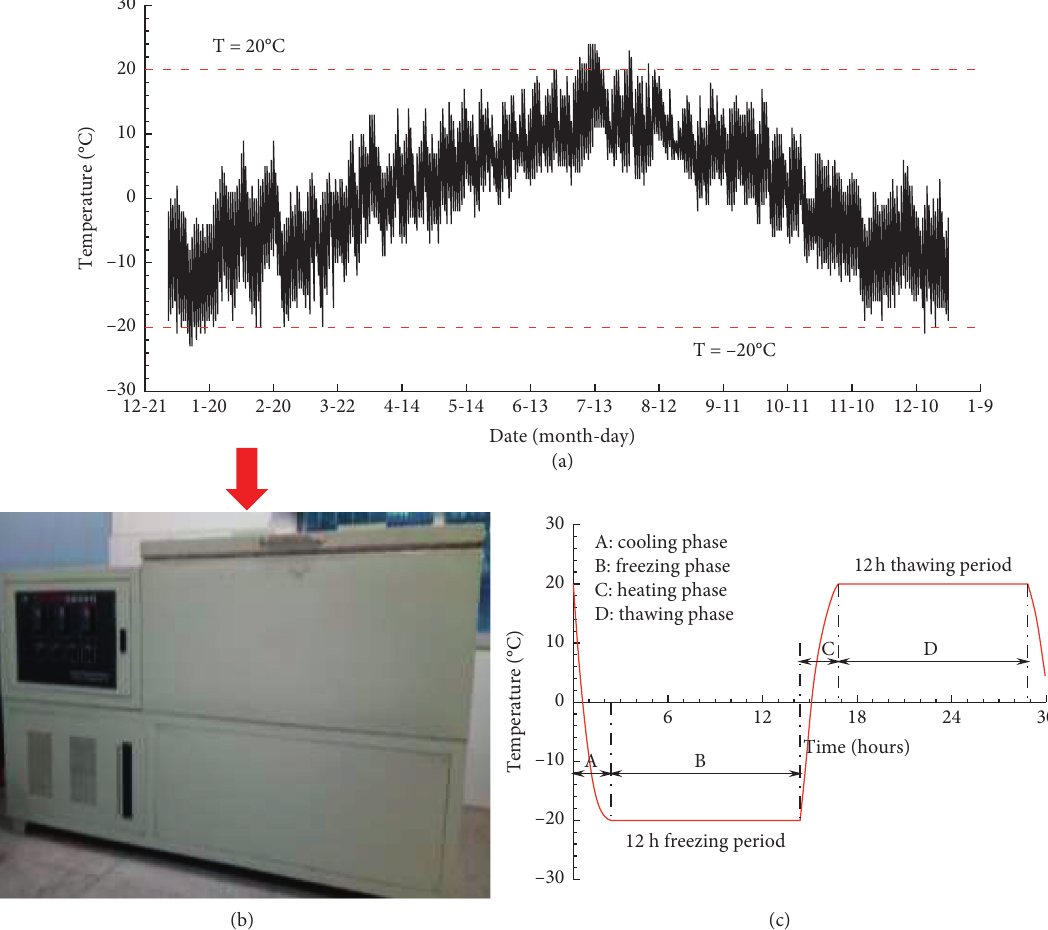
Figure 3: F-Tcycle experimental procedures (adapted from [4]). (a) Characteristics of temperature changes at the location of the project. (b) TDS-300 automatic F-T cycling device. (c) Temperature control curve for each F-T. Table 1: Basic elastic parameters of surrounding rock with different numbers of F-T cycles.